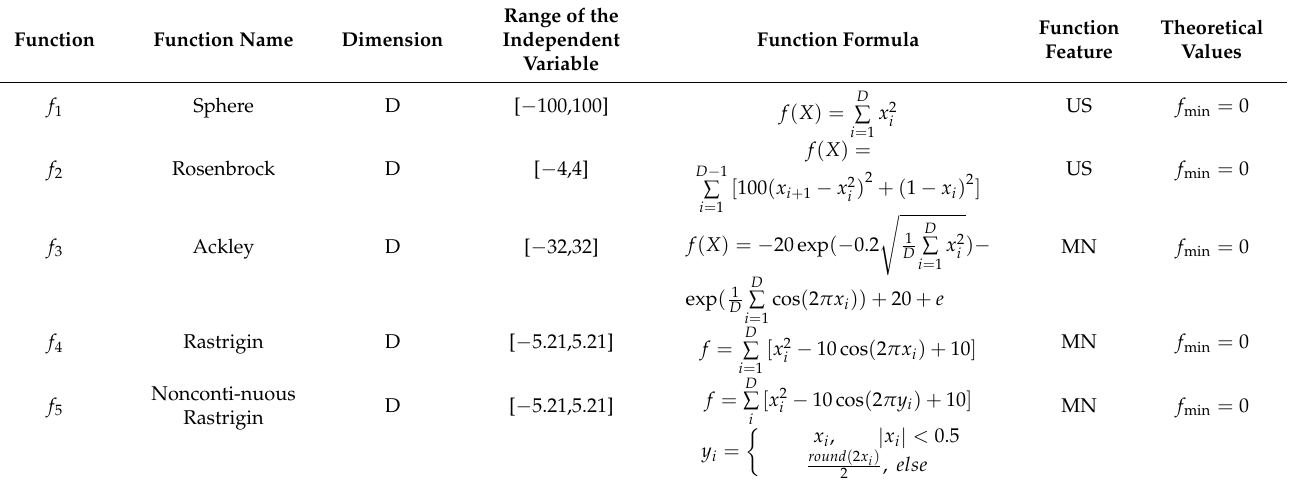
Table 1. Standard test functions.